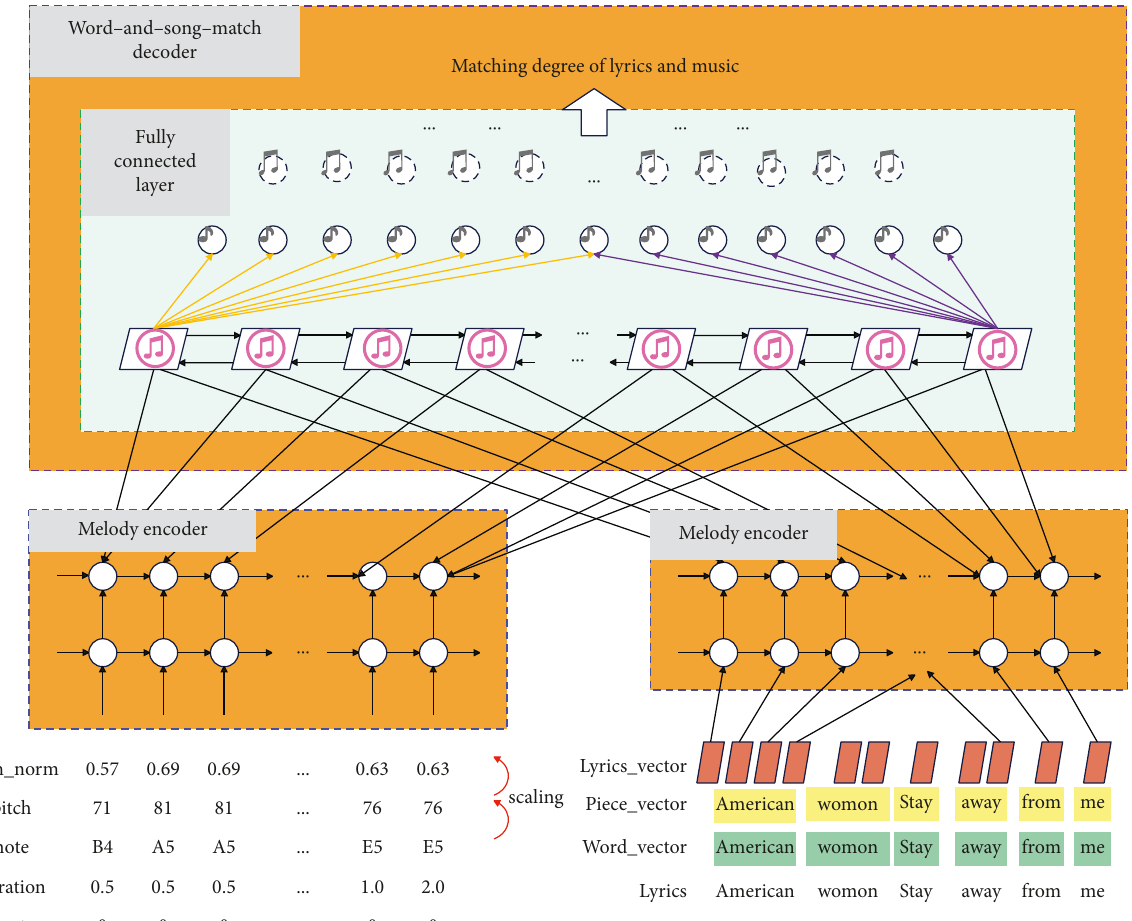
Figure 7: The framework of the word-song matching